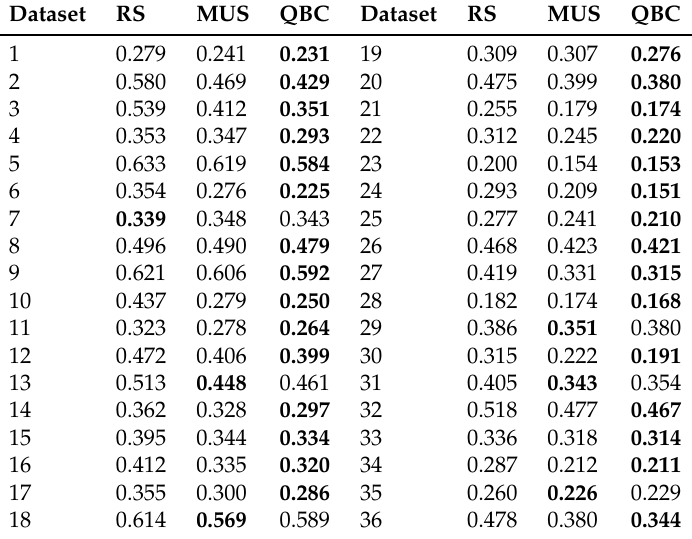
Table 3. Values of the average of E obtained in the 5th iteration of the algorithm for all strategies. The smallest value of E within query strategies is in bold.